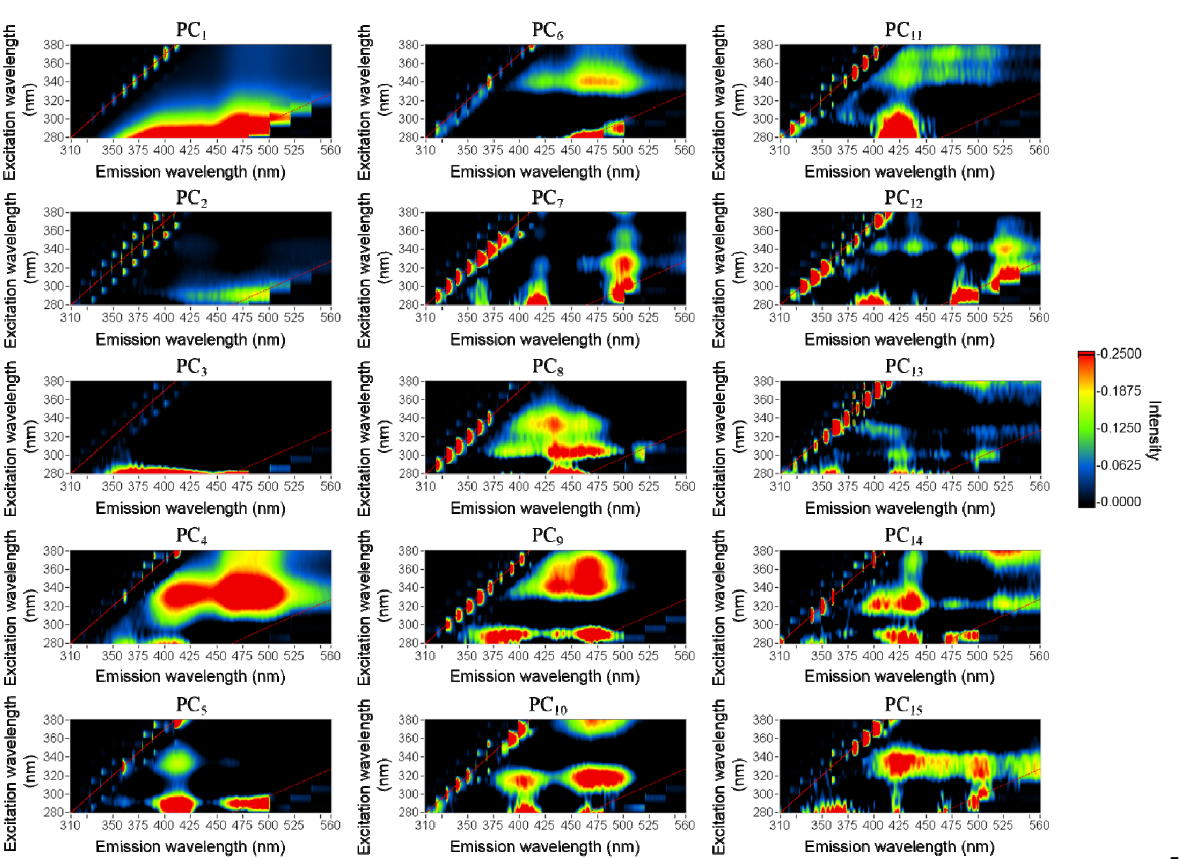
Figure 2. The first 15 principal components were considered the main components after